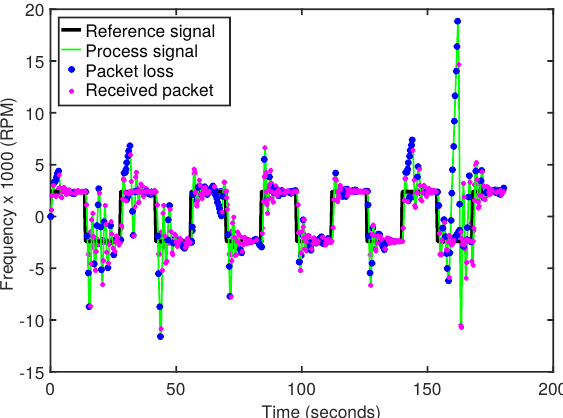
Figure 13. Unstable process operation with 30% of packet